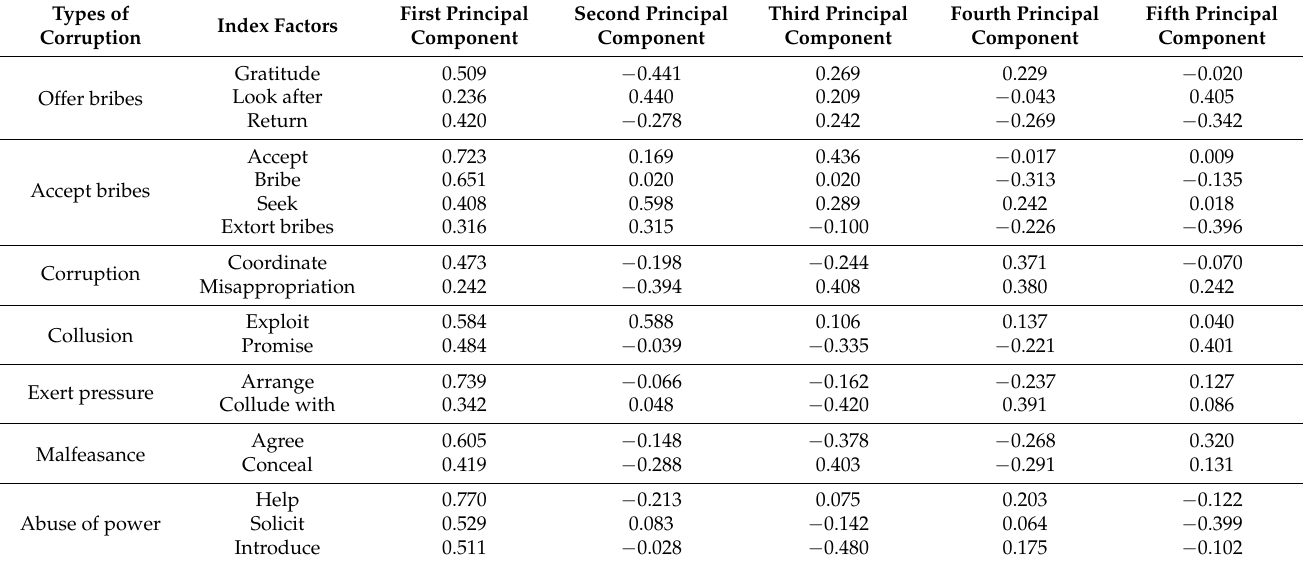
Table 5. Low-age corruptors’ corruption behavior characteristic indicator factor component matrix.